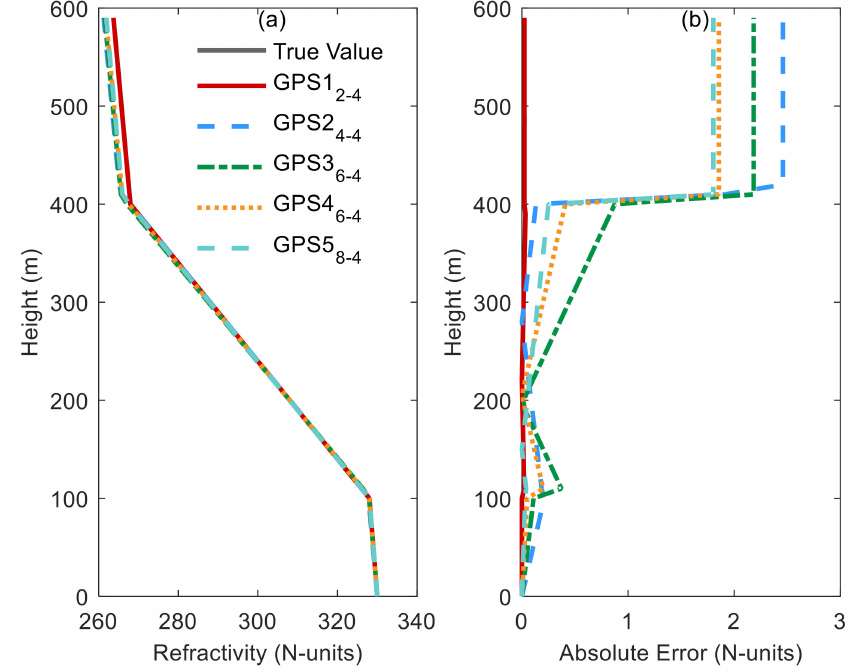
Figure 4. Comparison of di ff erent retrieved profiles by EN-MOEA / ACD-NS when considering the retrieval of four parameters. ( a ) is the simulated and retrieved profiles for di ff erent GPS problem; ( b ) is the absolute error of retrieved profiles for di ff erent GPS